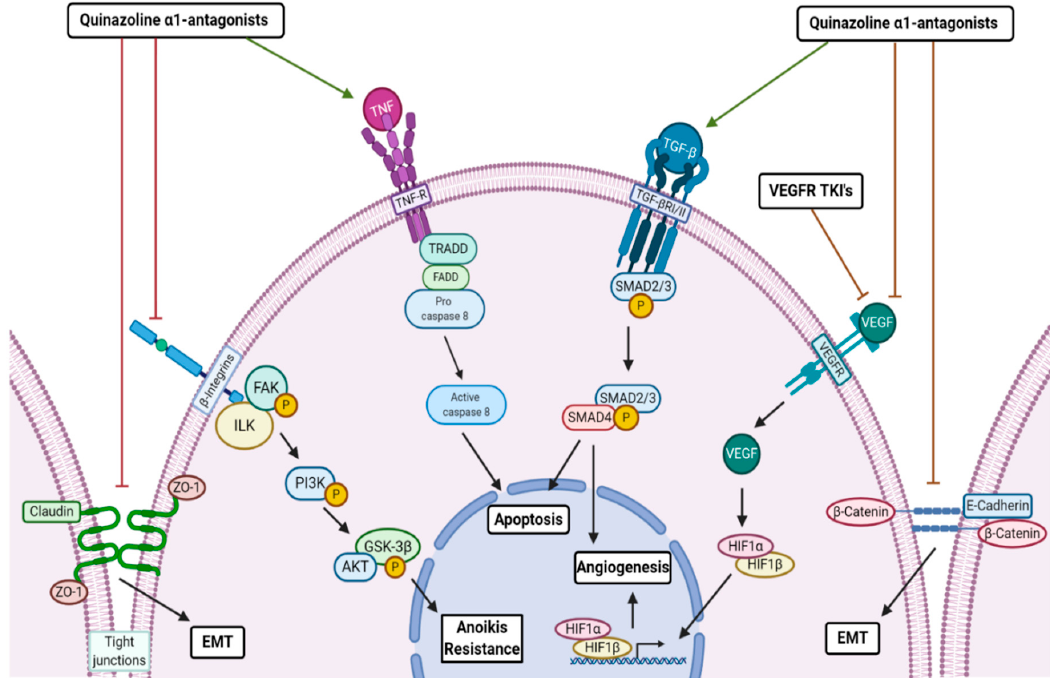
Figure 1. Biological Mechanisms of Anti ‐ tumor Action of Quinazoline α 1 ‐ Adrenoceptor Antagonists. Schematic diagram demonstrating the signaling mechanisms potentially targeted by quinazolne α 1 ‐ andrenoceptor antagonists in attenuating renal tumor initiation and progression to metastasis. Quinazoline based α 1 ‐ andrenoceptor antagonists influence the interconversion of epithelial– mesenchymal ‐ transition (EMT) to mesenchymal–epithelial ‐ transition (MET) phenotypes by targeting tight junctions and E ‐ cadherin ‐ mediates cell adherence. Tumor cells succumb to anoikis by disruption of integrin ‐ mediated cell survival via integrin ‐ linked kinase (ILK). Quinazoline based α 1 ‐ andrenoceptor antagonists induce apoptosis by either tumor necrosis factor (TNF) ‐ mediated Fas ‐ associated death domain (FADD)/caspase 8 activity and DNA fragmentation and/or Smad4 activation and apoptotic gene induction by transforming growth factor (TGF) ‐β . Angiogenesis is inhibited by vascular endothelial growth factor receptor (VEGFR)–tyrosine kinase inhibitors and quinazoline based α 1 ‐ andrenoceptor antagonists can also target tumor vascularity by disruption of VEGF ‐ mediated HIF1 transcriptional expression and potentially TGF ‐β signaling. 3. Antitumor Effects of α 1 ‐ Adrenoceptor Antagonists Table 1 summarizes the updated evidence from clinical, translational and epidemiological studies, suggesting the antitumor action of α 1 ‐ adrenoceptor antagonists in human malignancies. The published work from our group and other investigators makes a strong case in support of the repurposing of the α 1 ‐ adrenoceptor antagonists (with a good safety profile) and advance our current understanding of the clinical value of these therapeutic modalities for the treatment of GU ‐ cancers including renal cancer Table 1. Therapeutic Impact of α 1 ‐ Adrenoreceptor Antagonists Use against Human Cancers. Drug